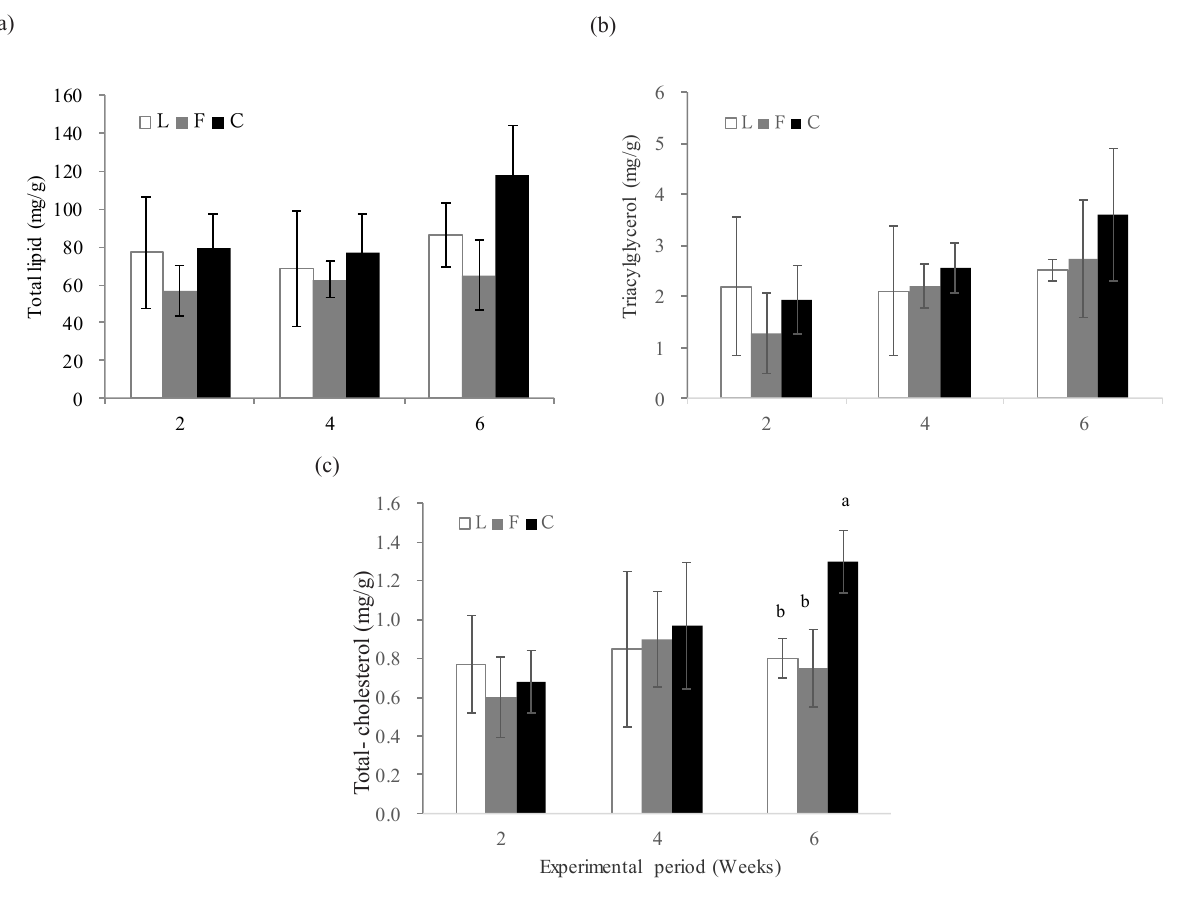
Figure 1: Liver lipids in mice fed experimental diets; L: lard diet; F: fish oil diet; C: coconut oil diet. Values represent mean ± SD (n=5). Within a grouping, values not sharing a common superscript letter are significantly different at p <